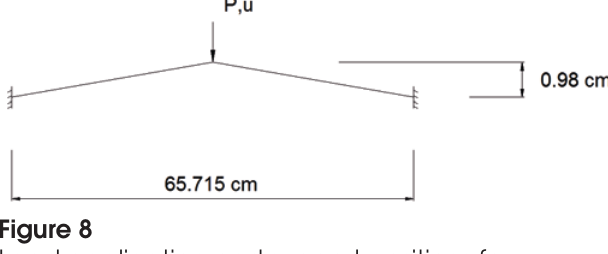
Load application and support positions for Williams’ frame (Petersson and Petersson [31])